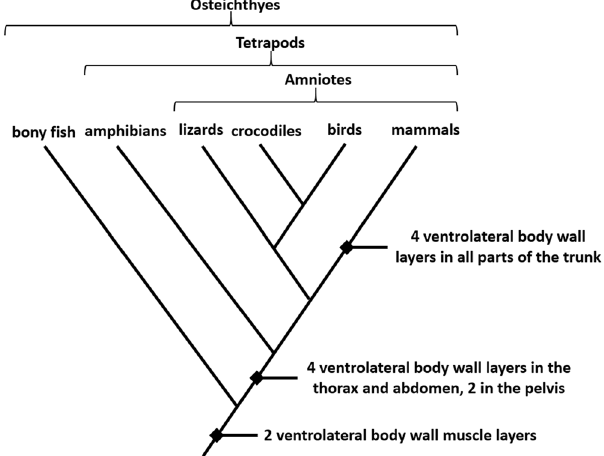
Figure 1. Cladogram of major vertebrate classes demonstrating the evolution of ventrolateral body wall muscle layers. Primitively, vertebrates have two ventrolateral muscle layers, while most tetrapods have four layers in the thorax and abdomen. Mammals exhibit four layers throughout the trunk, including the perineal portion of the body